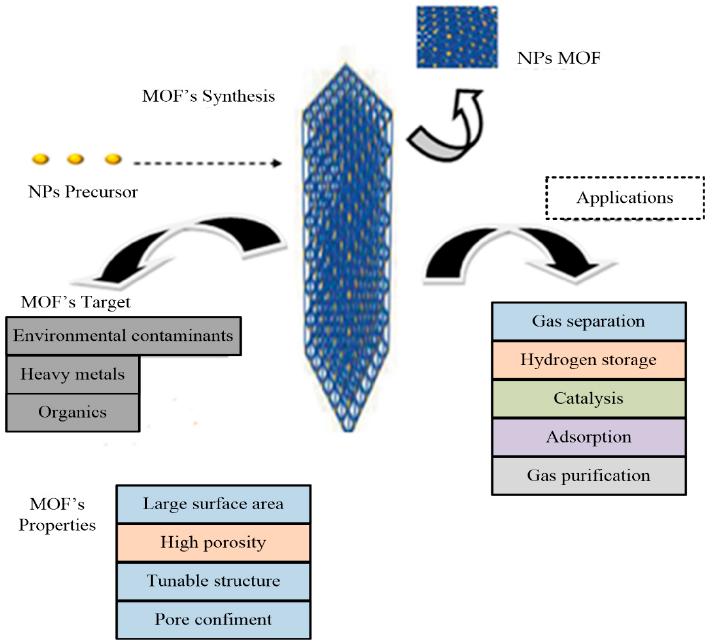
Figure 7. Schematic diagram of MOF properties and applications.